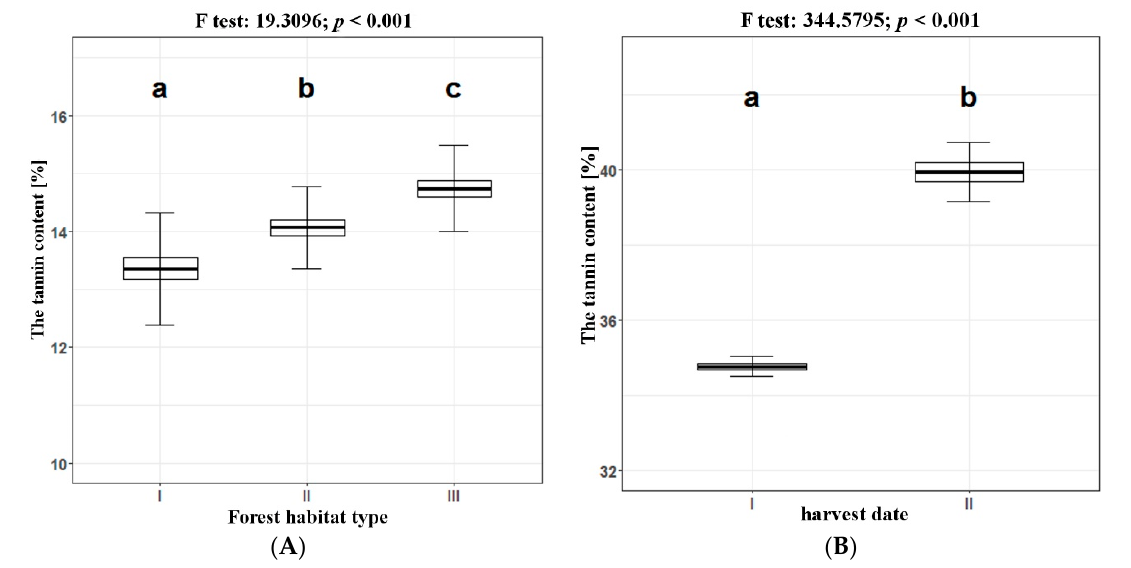
Figure 1. ( A ) The influence of forest habitat type on the content of tannins in Cynips quercusfolii gall nuts (I, moist mixed broadleaved forest, II, fresh broadleaved forest, III, moist broadleaved forest); ( B ) The influence of the harvest date on the content of tannins in Andricus infectorius gall nuts (I, August, II, September). Letters (a, b, c) are used to determine if statistically significant differences between factors exist. The same letter (for example, ‘a’) means there is no statistical difference.